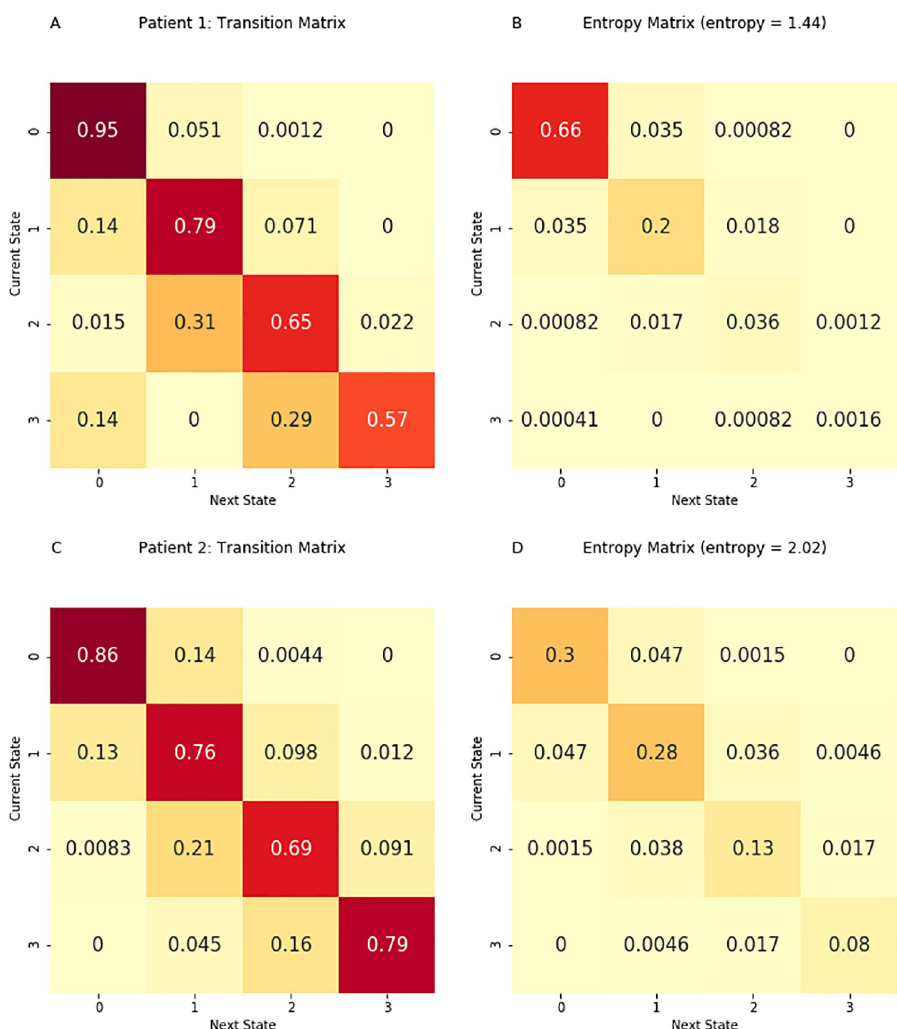
Fig 5. Transition and entropy matrices. The transition matrices for patient 1 (A) and patient 2 (C) show the probabilities of transitioning from a current illness state, denoted by rows, to the subsequent state, denoted by columns. In the entropy matrices for patient 1 (B) and patient 2 (D), the probabilities are normalized from all initial illness states. The figure may be interpreted as follows. The entropy matrix for patient 2 (D) corresponds to an entropy of 2.02, higher than the entropy of 1.44 for patient 1 (B). Patient 2 has a more uniform distribution of transition probabilities than patient 1, whose distribution of probabilities is steeply peaked in row 1, column